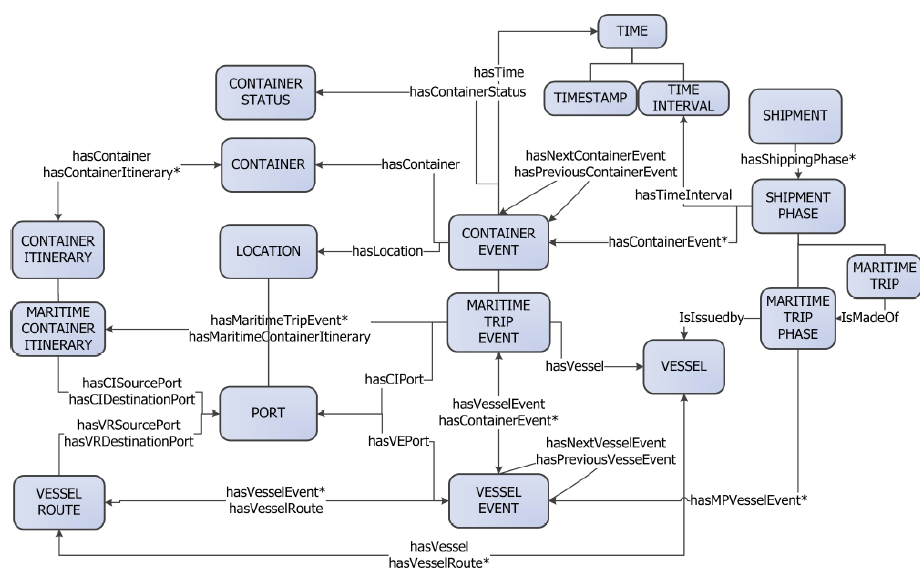
Figure 9. An excerpt of the Maritime Container Ontology